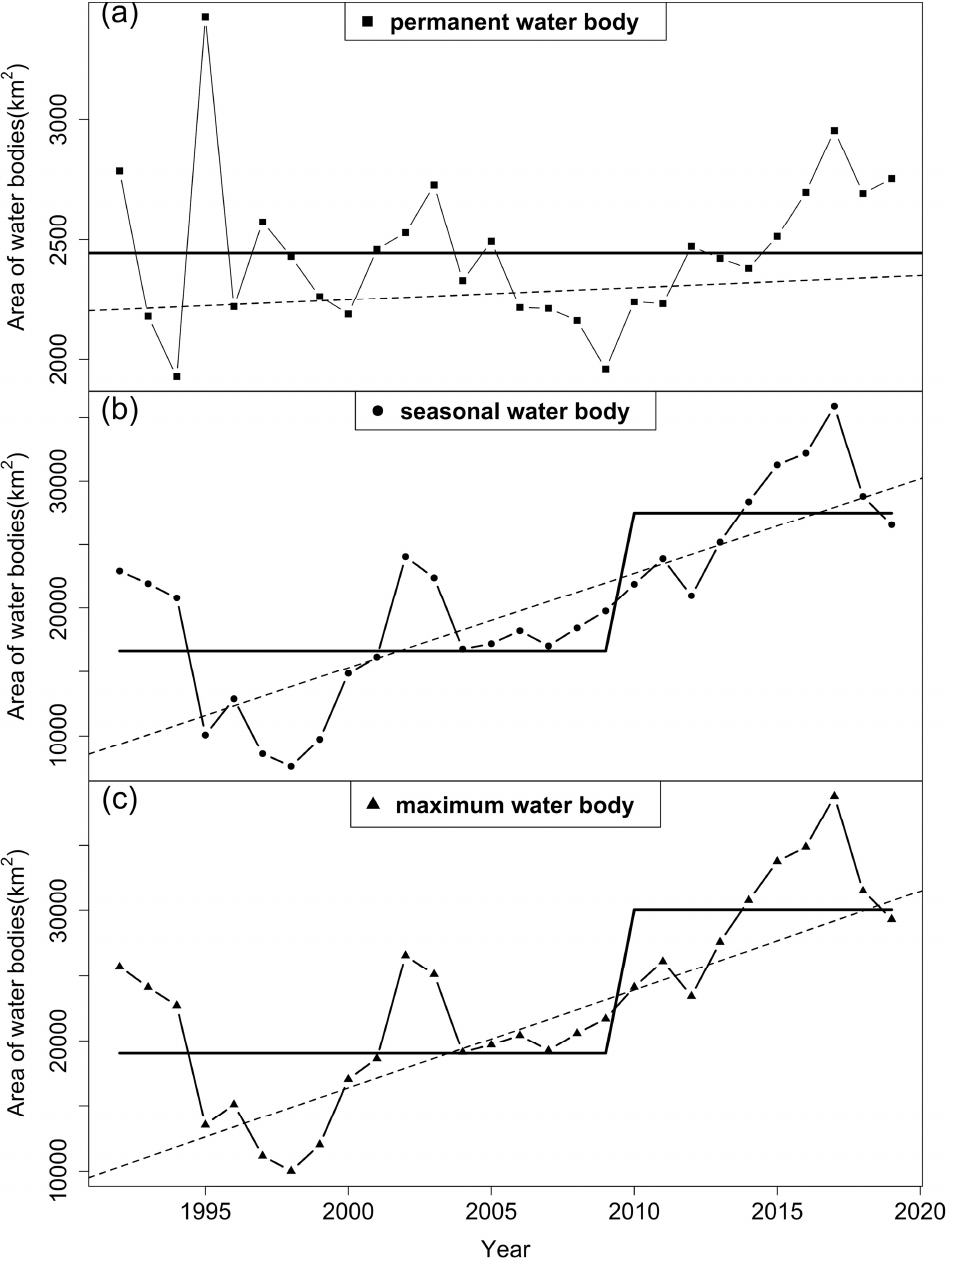
Figure 9. The inter-annual dynamics of water bodies areas during 1992–2019, with the Theil–Sen (TS) trends fitted in dashed lines and the average annual area regime shifts denoted in bold lines: ( a ) permanent water bodies; ( b ) seasonal water bodies; and ( c ) maximum water